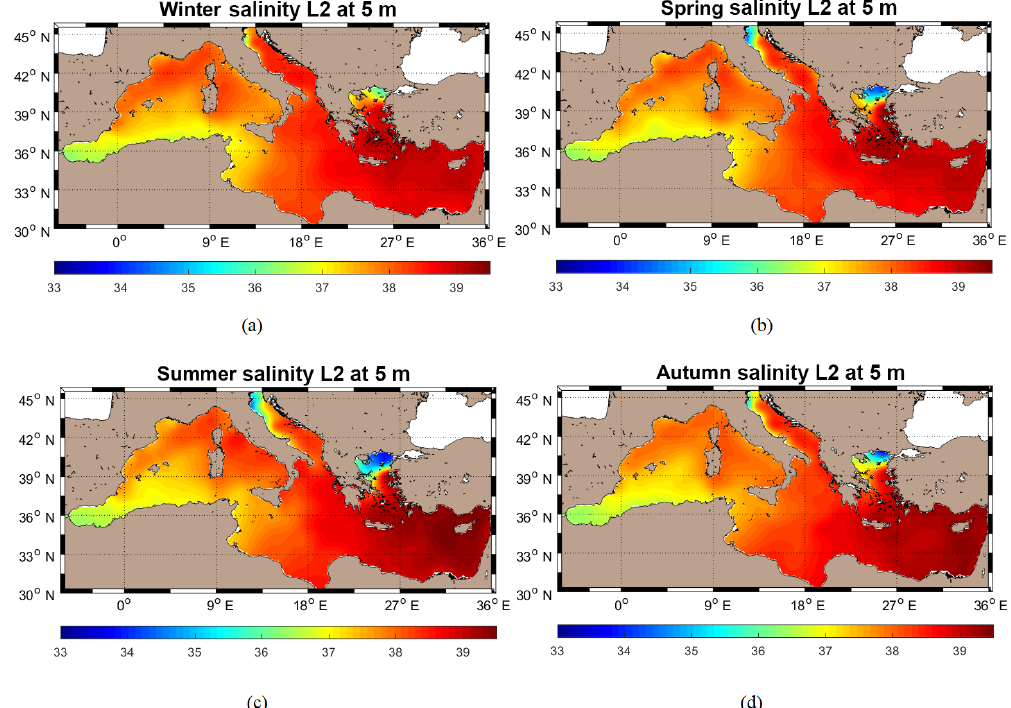
Figure 6. Surface salinity climatology at 5m for (a) winter, (b) spring, (c) summer, and (d) autumn.